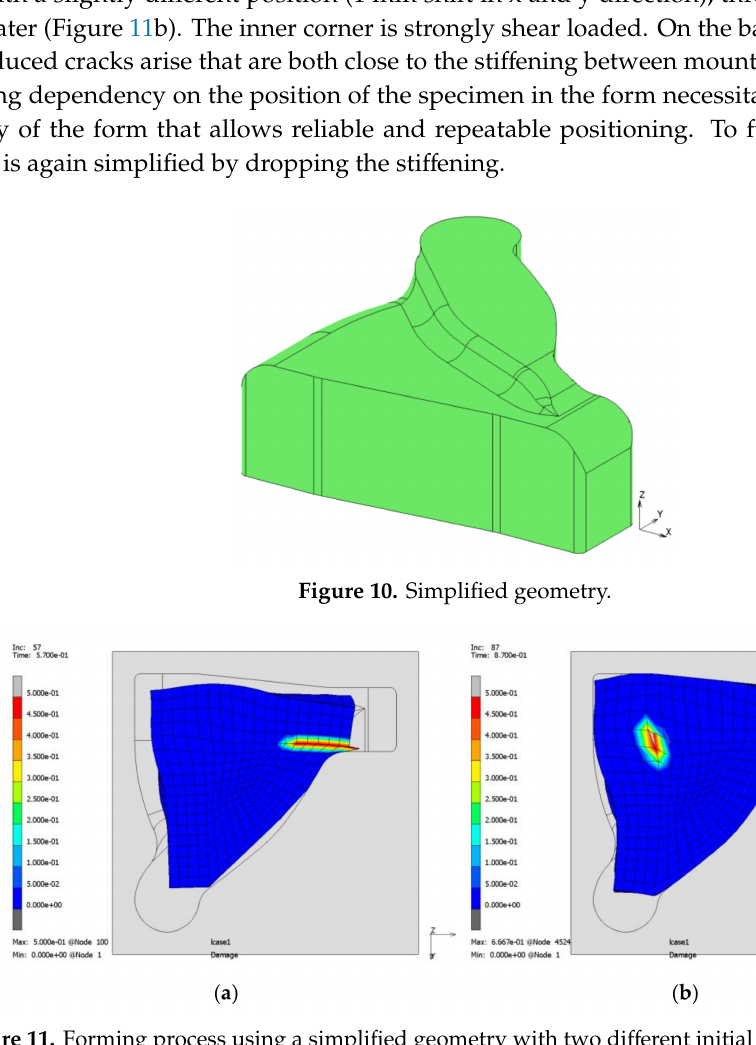
Figure 11. Forming process using a simplified geometry with two di ff erent initial positions ( a ) and ( b ) of the specimen in the form: joining zone